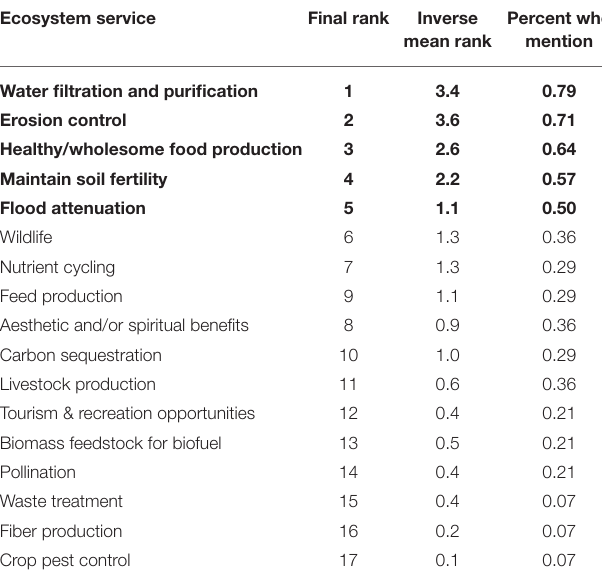
TABLE 3 | Ecosystem services important to and obtainable from Iowa’s agricultural landscapes developed from participant ranking in the final round of a Delphi